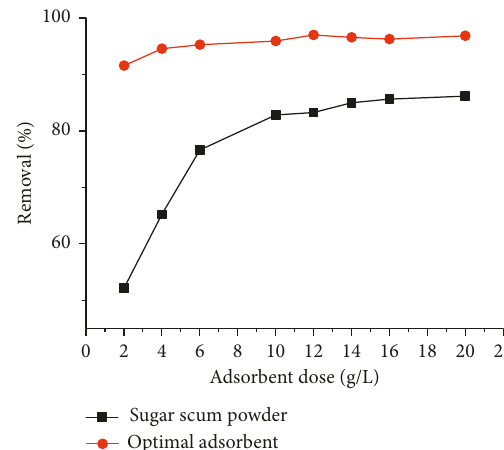
Figure 4: Effect of adsorbent dose on the adsorption of methylene blue onto optimal adsorbent and sugar scum powder (contact time 24h; [MB] � 100mg · L − 1 ; T � 25 °